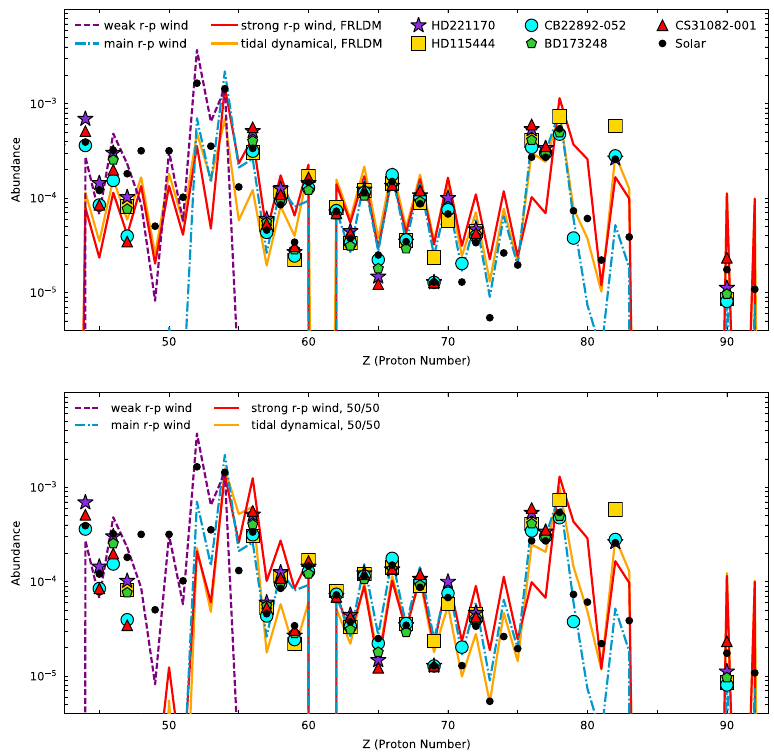
Figure 4. The elemental abundances predicted by nucleosynthesis calculations at 1 Gyr for dynamical merger tidal-tail ejecta [25] (orange) as compared to three distinct conditions all present within a simu- lation of accretion disk wind ejecta [30]: a weak r process which does not synthesize elements beyond the second r -process peak (purple dashed), a main r process which mostly populates nuclei between the second and third r -process peaks and weakly produces actinides (blue dashed-dotted) and a strong r process which robustly reaches very neutron-rich, fissioning species. The top panel shows results using FRLDM fission yields and the bottom panel shows these cases using 50 / 50 symmetric splits. The solar and stellar abundance data is from